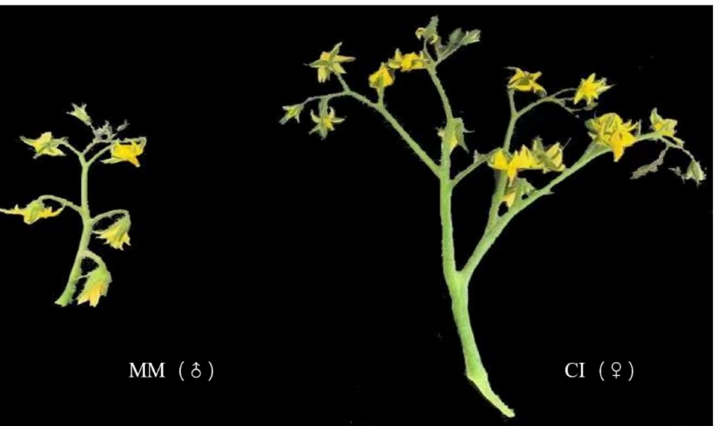
Figure 10. Appearance of the parental materials used for transcriptome analysis. MM (Moneymaker) was used as the male parent, and CI (Compound Inflorescence) was used as the female